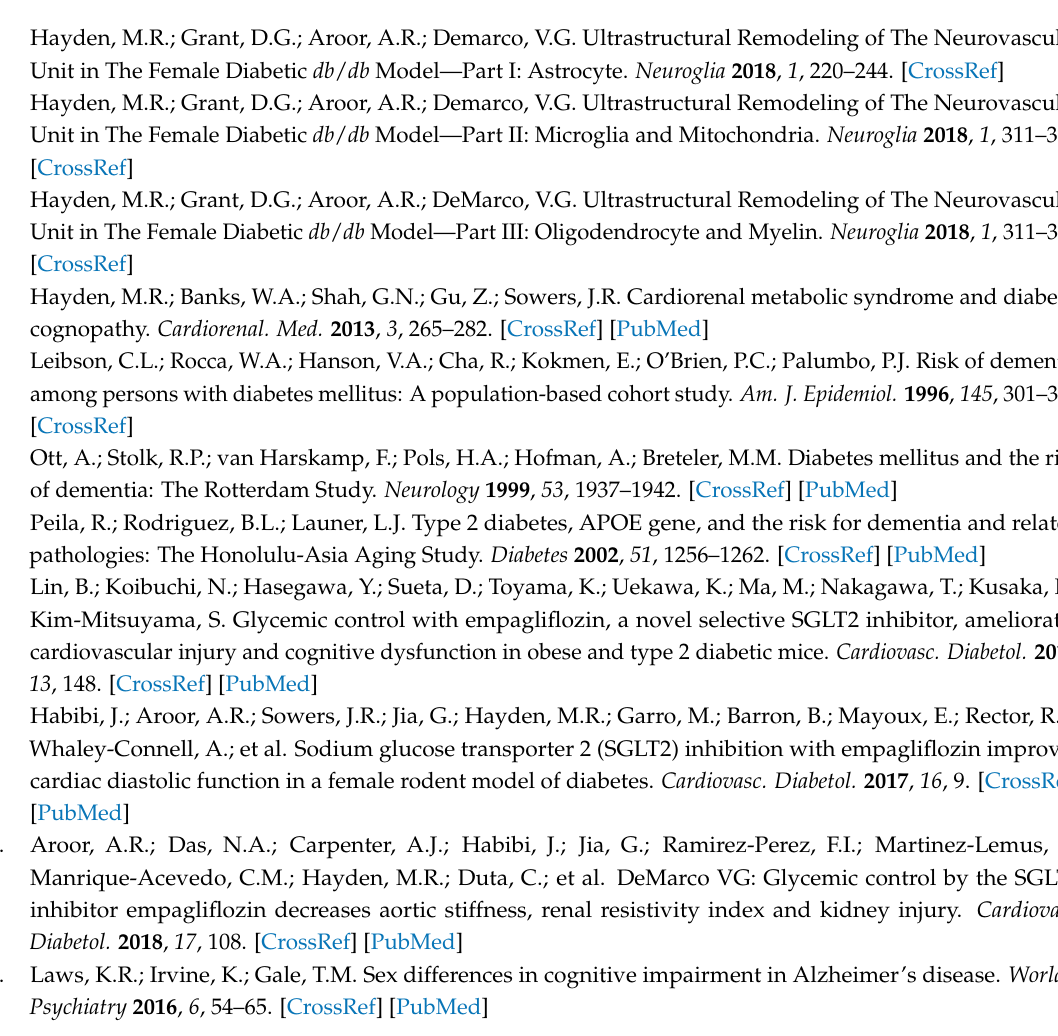
DBE with legend. Figure S1: Supplemental Fixed Image 1; Figure S2: Supplemental Fixed Image